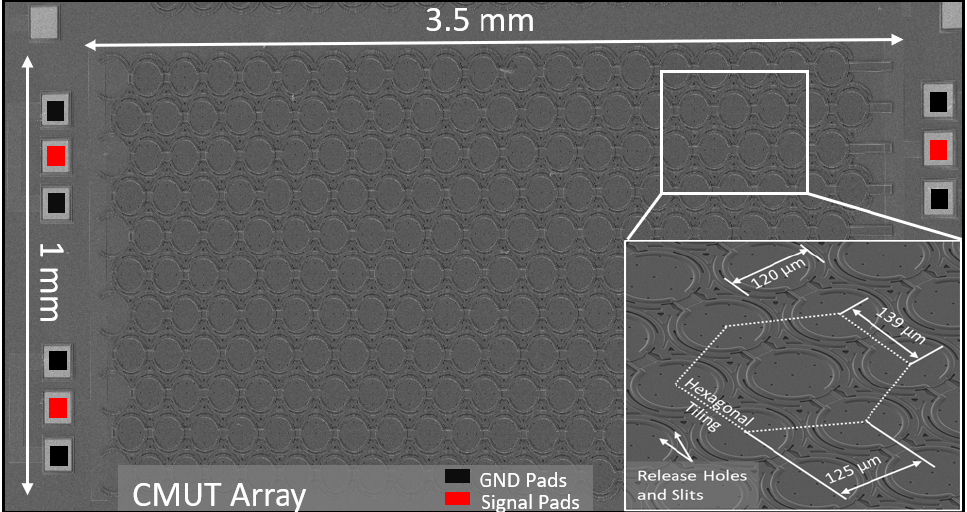
Figure 3. SEM image of the fabricated CMUT array with a hexagonal element distribution.